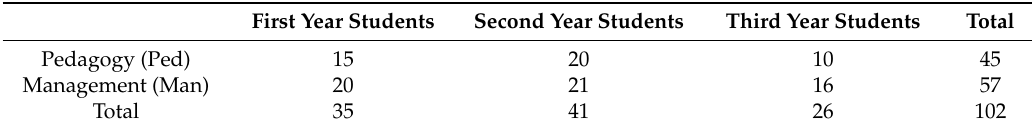
Table 1. Number of respondents in researched